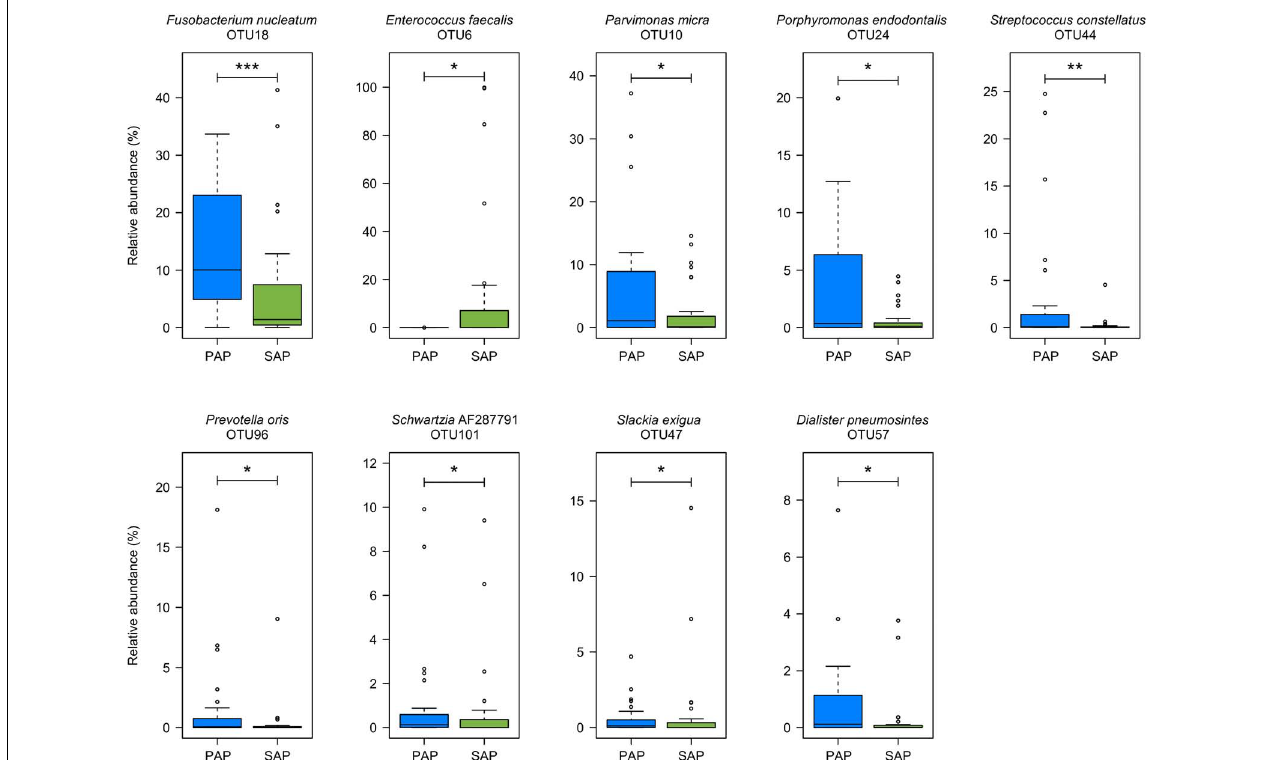
FIGURE 3 | OTUs differentially represented between PAP and SAP root samples. OTUs with significant changes (Wilcoxon rank-sum test, P < 0.05) and a minimum average relative abundance ≥ 0.5%) are presented. Boxplots show the first and third quartile (top and bottom edges of the rectangle) divided by median. Whiskers correspond to the highest and lowest values within 1.5 × the interquartile range. Outliers are shown as circles. ∗ 0.01 < P < 0.05; ∗∗ 0.001 < P < 0.01; ∗∗∗ P < 0.001. PAP, primary apical periodontitis; SAP, secondary apical periodontitis.